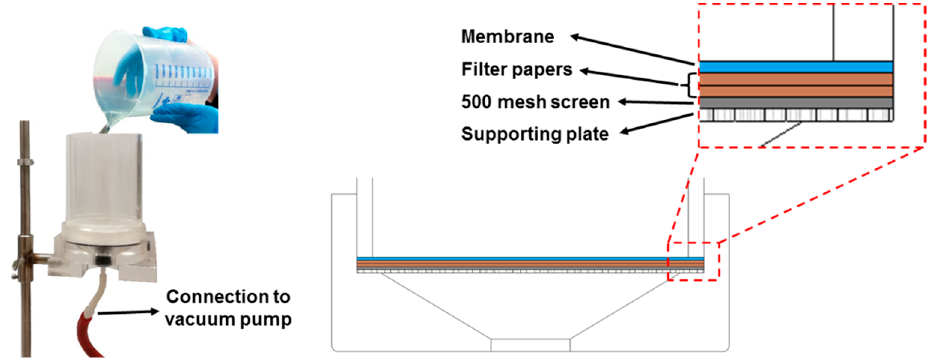
Figure 3. Equipment used for fines and MFC sheet formation.